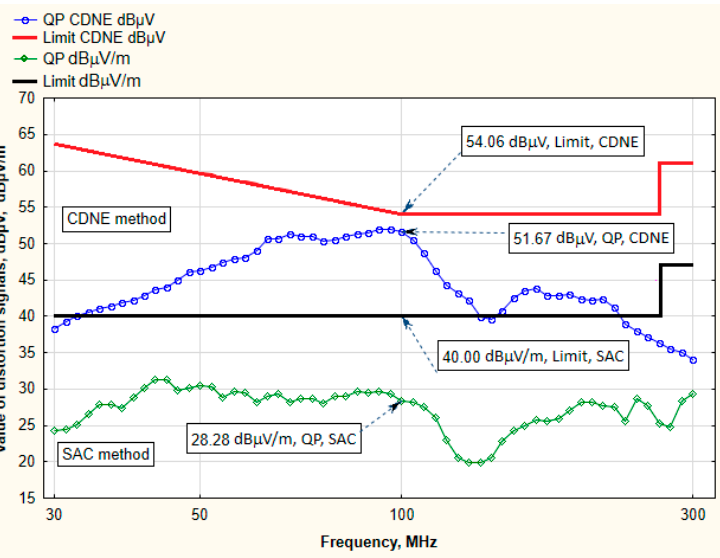
Figure 7. Recorded QP values using CDNE and SAC methods against the allowable limits for the tested LED lamp A.